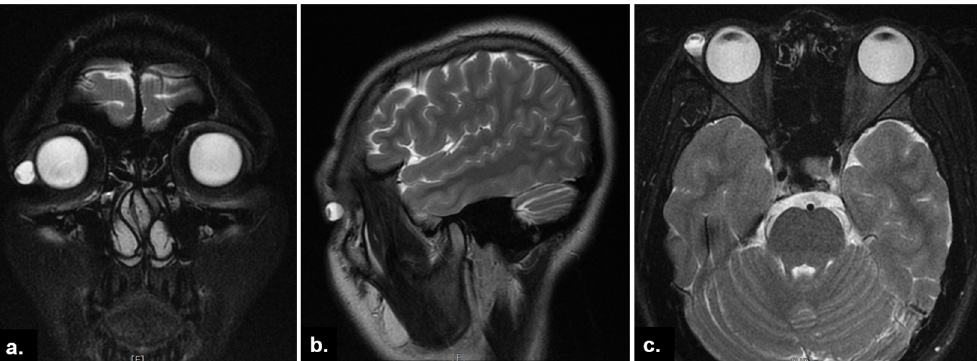
Figure 2. Orbital magnetic resonance images (T2-weighted). ( a ) The coronal image showed a well- defined periocular lesion adjacent to the lacrimal gland; ( b ) sagittal and ( c ) axial images revealed the distinct air-fluid level within the lesion.